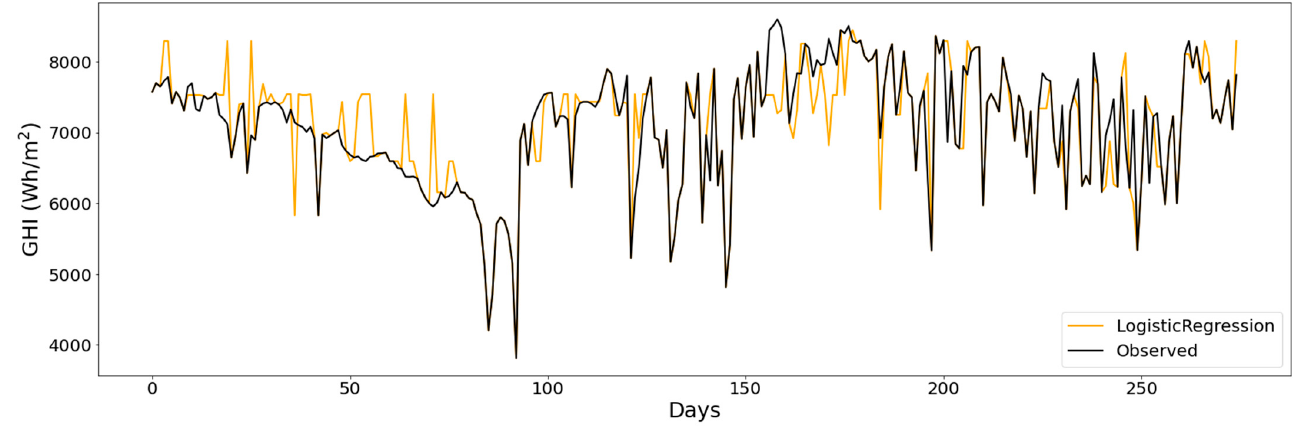
Figure 9. Graphical representation of logistic regression predictions.